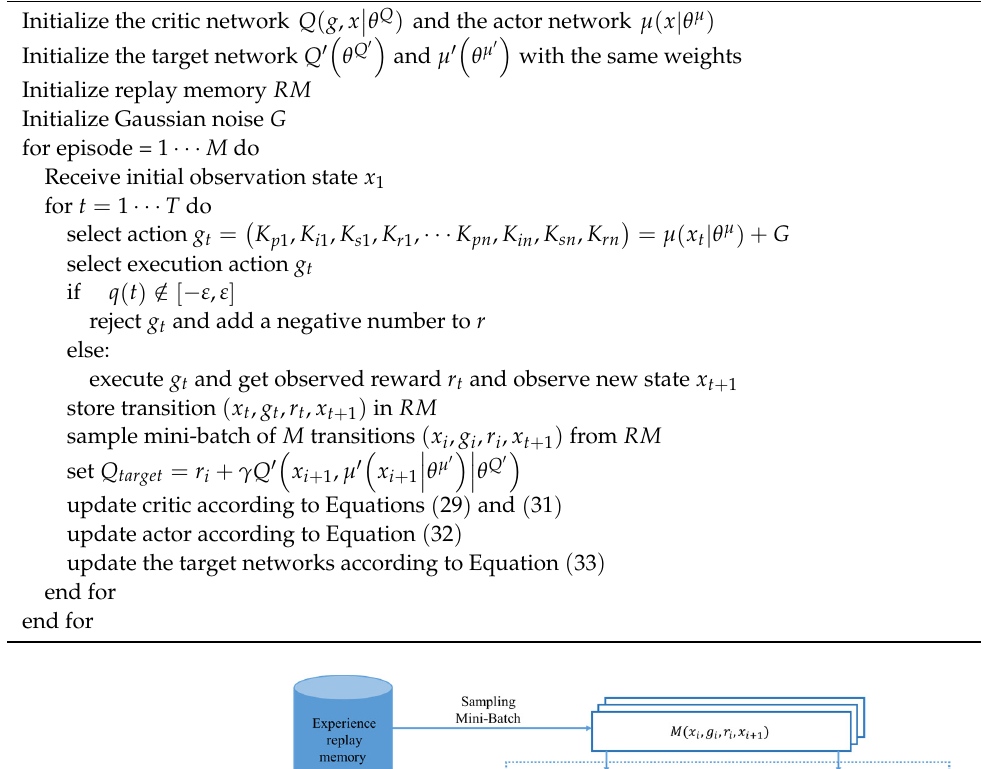
Algorithm 1. DDPGPIR Algorithm.